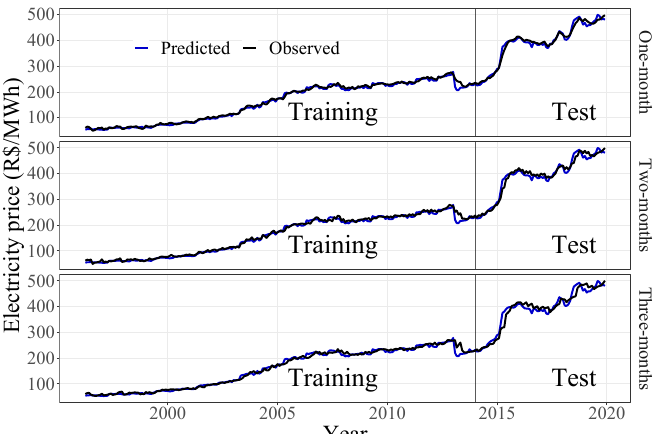
Figure 9. Predicted and observed Brazilian industrial electricity prices.